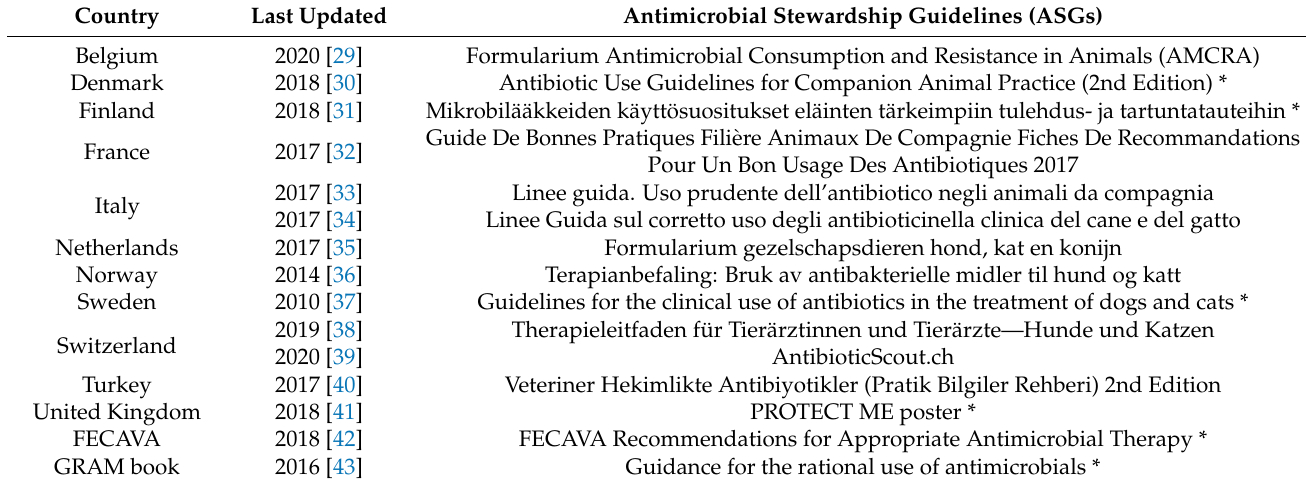
Table 1. ASGs included in this study.